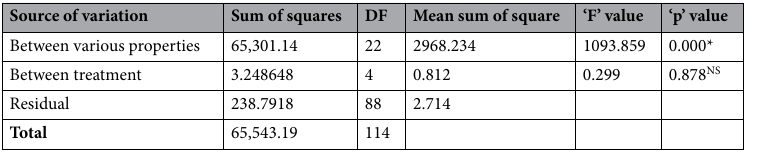
Figure 21. Total hand value.